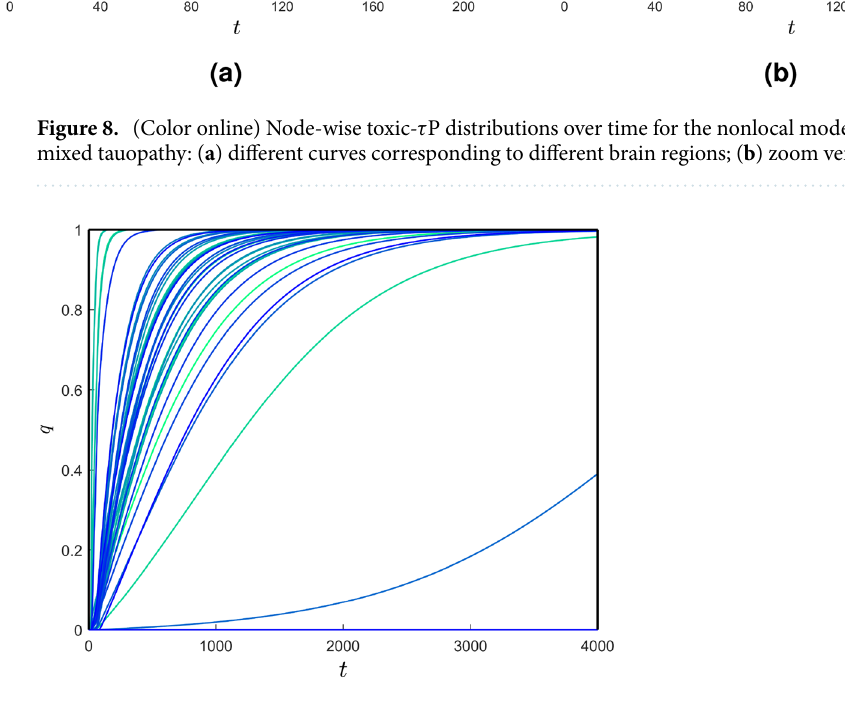
Figure 9. (Color online) Region-wise damage for the nonlocal model with mixed